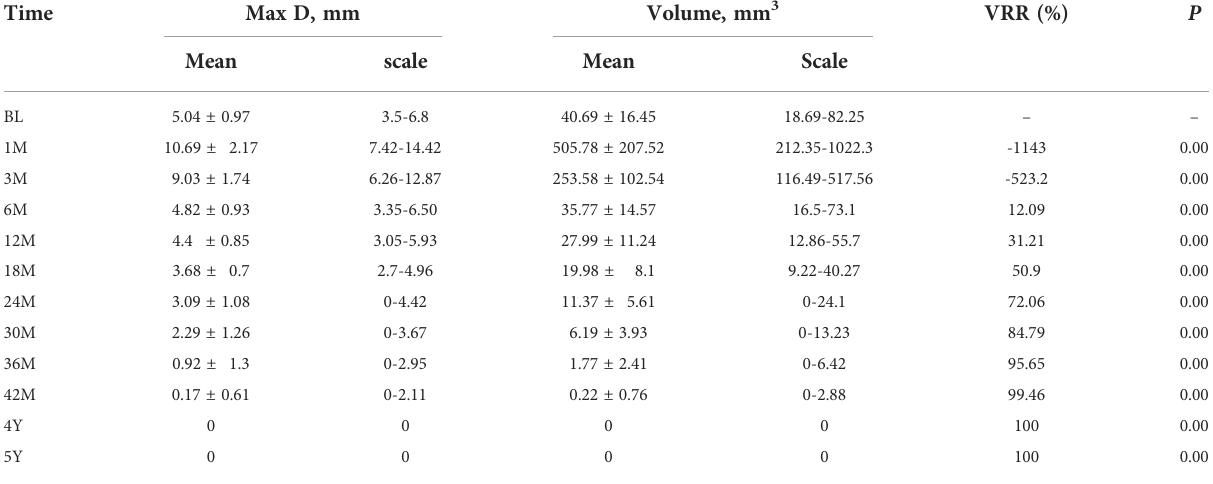
TABLE 2 Outcomes of PTMC treated after ultrasound guided PLA.